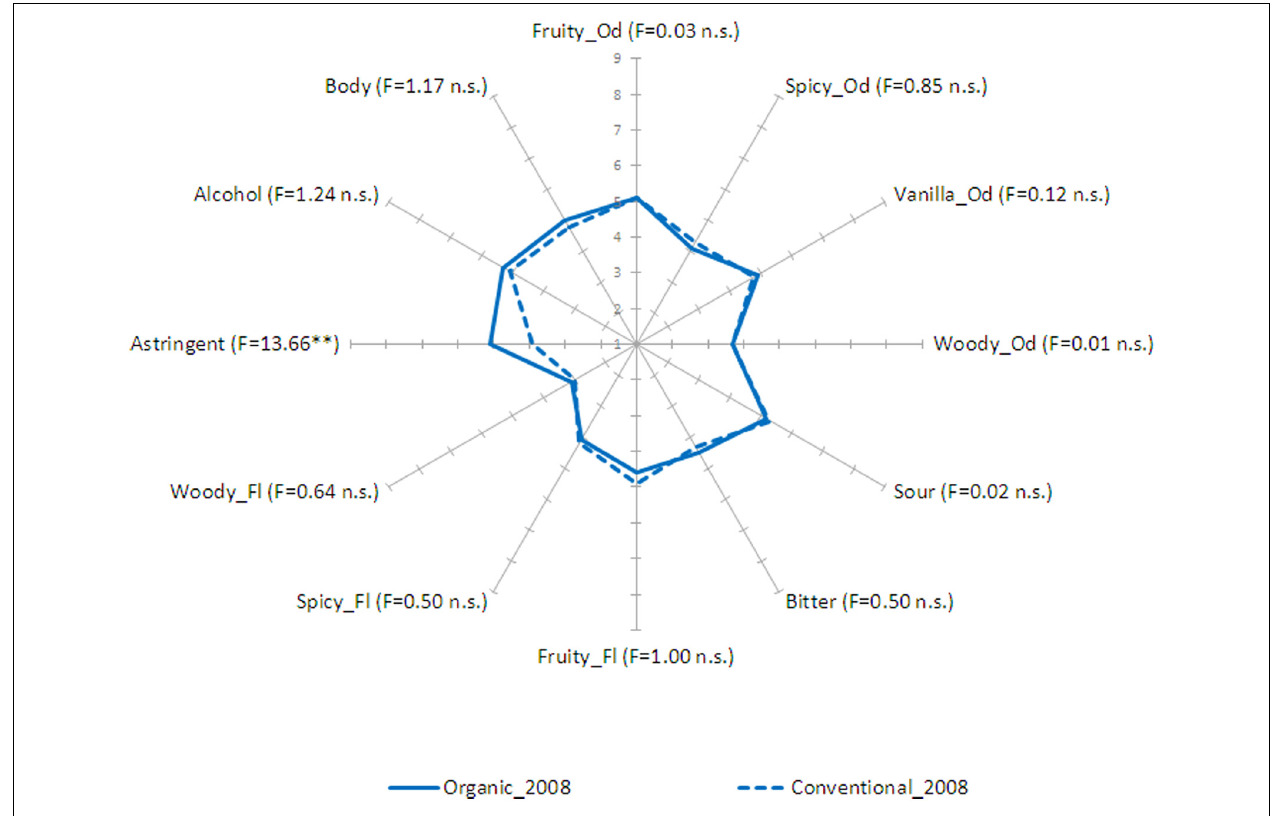
FIGURE 2 | Descriptive analysis results: mean values for each sensory descriptor by method of production (organic vs. conventional) for vintage 2008. For each descriptor the relevant significance is reported (** p < 0.01).